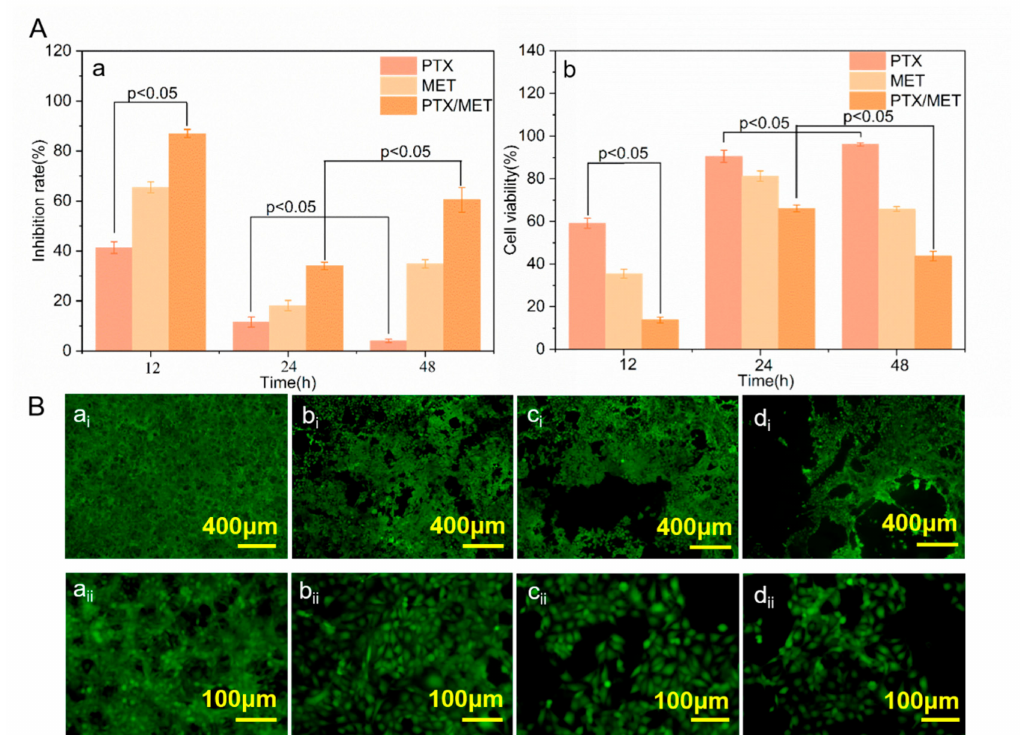
Figure 6. ( A ) Inhibition rate and cell viability of HUVECs: ( a ) Inhibition rate ( b ) Cell viability; ( B ) Growth status of HUVECs at 48 h: ( a i , a ii ) Cell growth between drug free stent samples; ( b i , b ii ) Cell growth between PTX coated stent samples; ( c i , c ii ) Cell growth between MET coated stent samples; ( d i , d ii ) Cell growth between PTX/MET coated stent